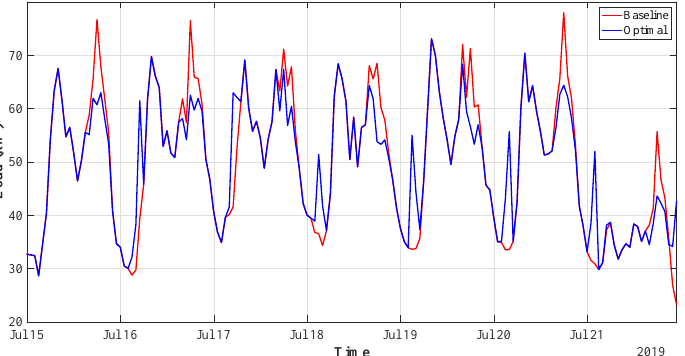
Figure 8. Marina’s load for different car charging